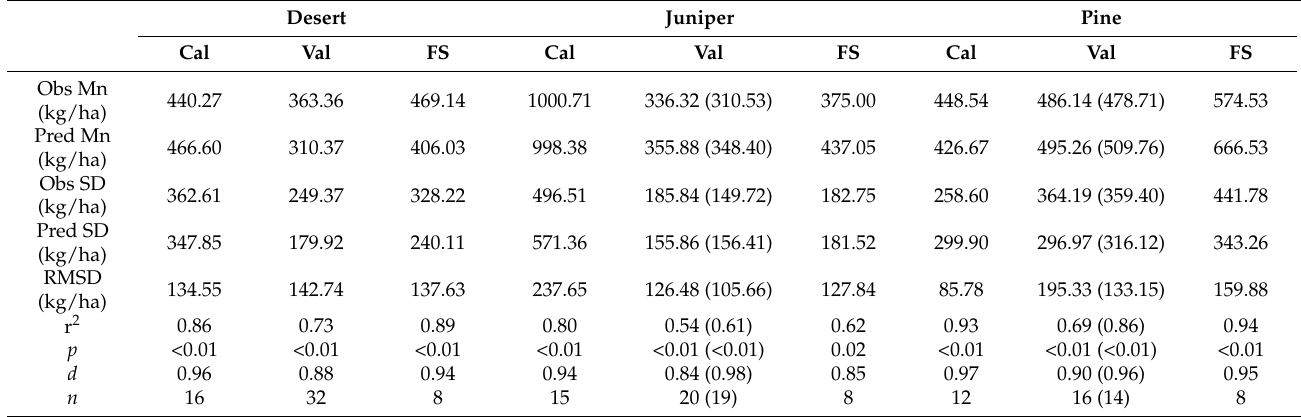
Table 2. Phygrow model calibration (Cal) full validation (Val), and fire season-only validation (FS) results for desert, juniper, and pine ecotypes. Metrics include observed mean (Obs Mn), predicted mean (Pred Mn), observed standard deviation (Obs SD), predicted standard deviation (Pred SD), root mean square difference (RMSD), r-squared (r 2 ), regression probability value ( p ), index of agreement ( d ), and number of observations ( n ). Data in parentheses () indicates the removal of outliers. Desert Juniper